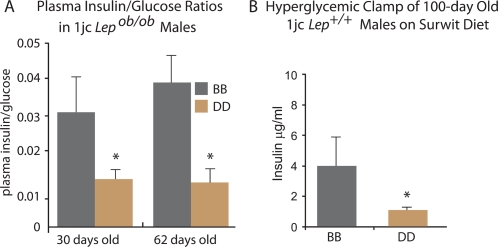
Plasma Insulin/Glucose Ratios and Hyperglycemic Clamps in Age-Grouped 1jc Congenic Males.A) Fasting plasma insulin/glucose ratios in 30- and 62-day old 1jc Lepob/ob B/B and D/D male mice, chow-fed since weaning. Raw data are shown in Table S1. Asterisk (*) indicates significant difference between B/B and D/D animals; p-value <0.05 for 2-tailed t-test. B) Hyperglycemic clamping in 100-day old 1jc males on Surwit Diet for 18 weeks. 1jc DD male mice fed a Surwit diet for 18 wks were clamped at a blood glucose concentration of 250 mg/dl for 1 hr and serum insulin concentrations measured at 1 hr. Asterisk (*) indicates p-value <0.05 for 2-tailed t-test.